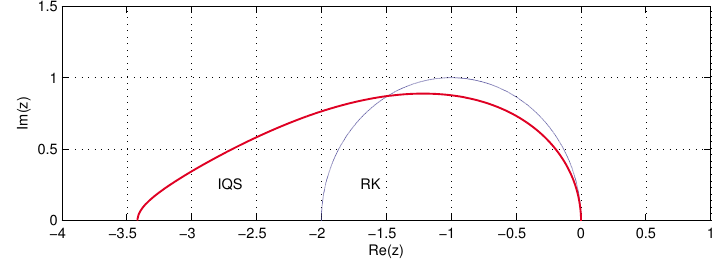
Figure 5. Stability regions of RK method of order p = 1 and GLMs with p = q = s = 1, r = 2 with